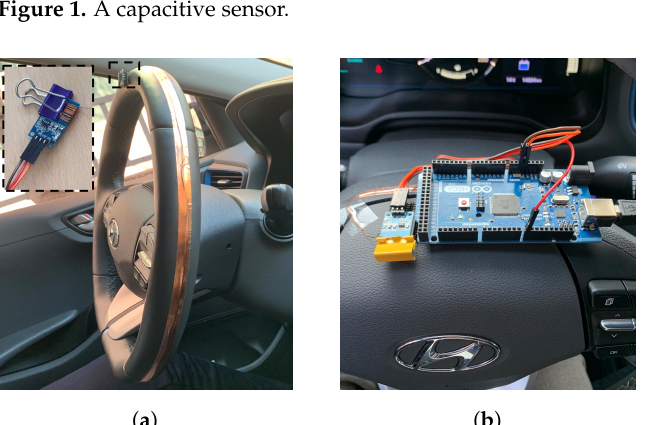
Figure 2. Data collection system. ( a ) The steering wheel covered with copper wire and tape; ( b ) a ca- pacitive sensor connected to an Arduino